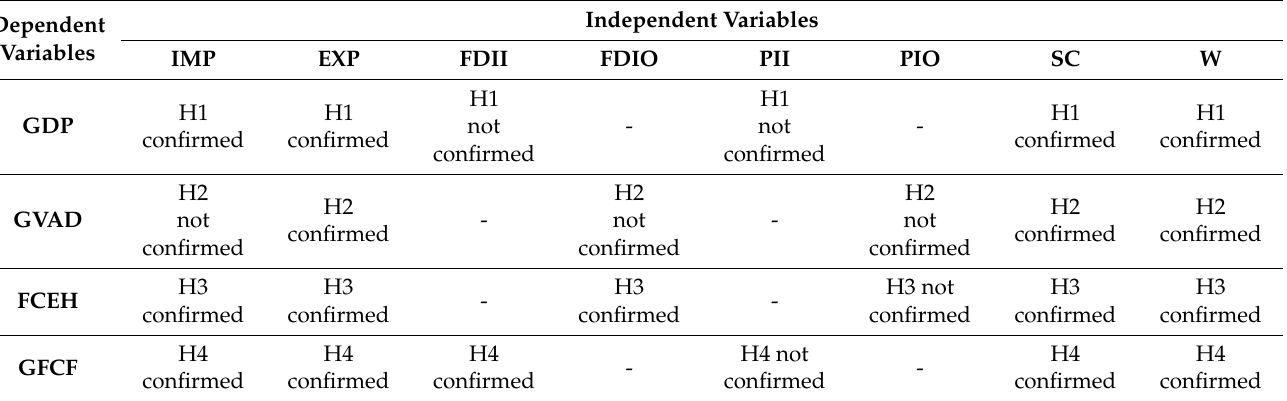
Table 5. Synthesis of the impact of independent variables on economic growth